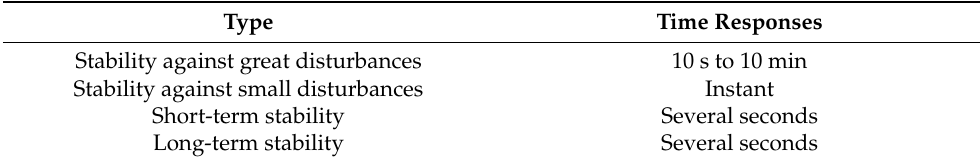
Table 2. Types of voltage stability analysis and their time